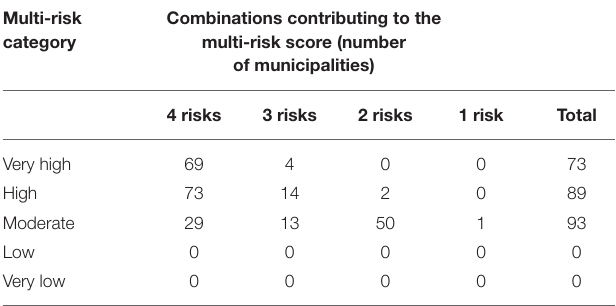
TABLE 5 | Contribution of single-risk combinations to multi-risk—number of municipalities. Multi-risk